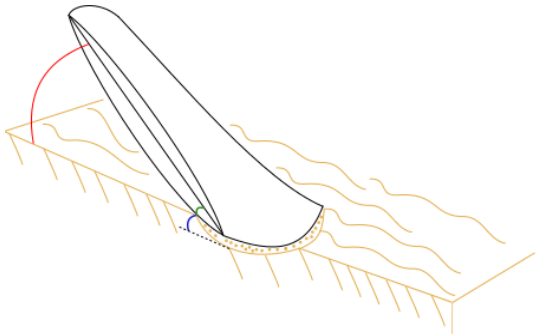
Figure 3. Schematic visualisation of the proposed impact angle analysis – Blue arc: Facet slope, Green arc: Replica head’s slope, Red arc: Impact